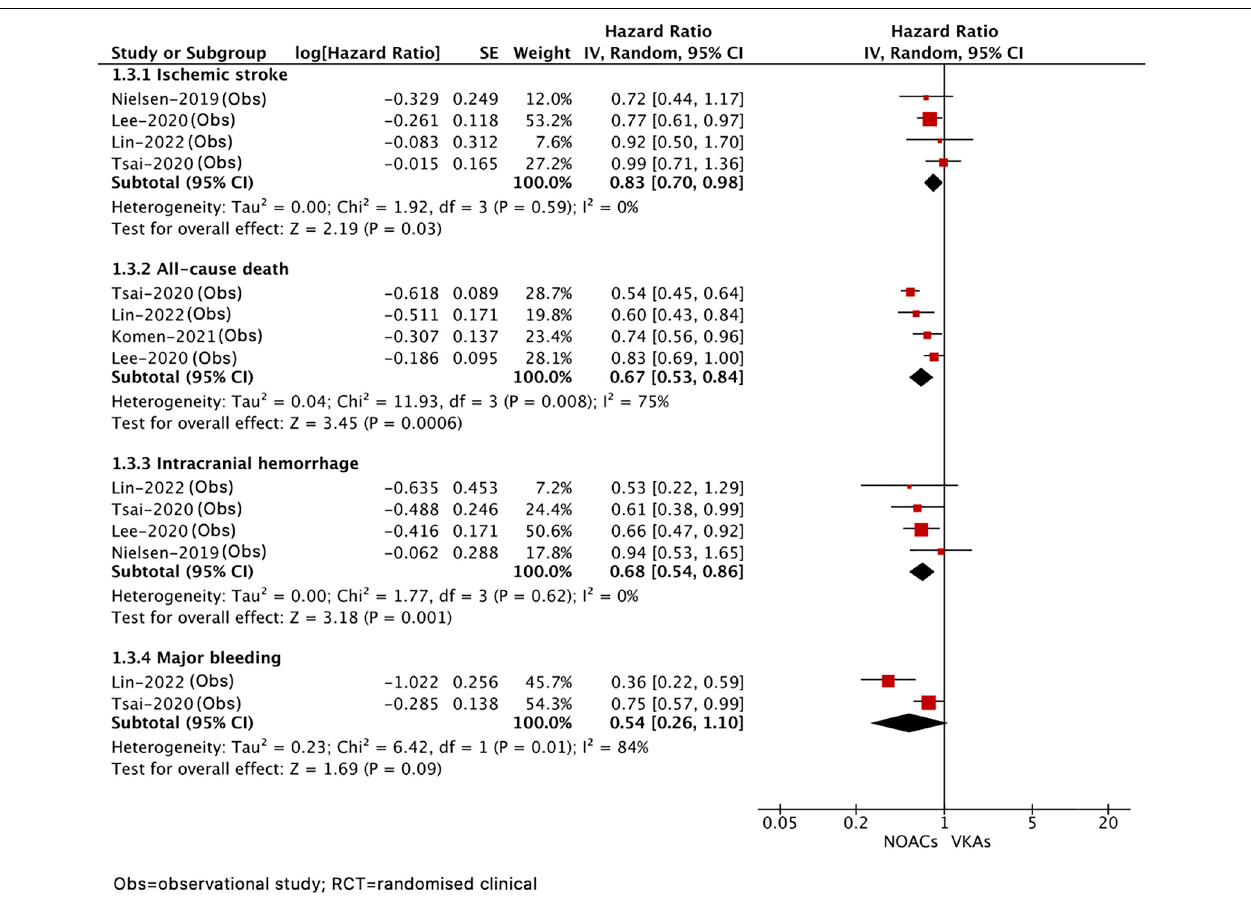
FIGURE 4 | Comparing the efficacy of NOACs with VKAs in patients with AF after ICH. AF, atrial fibrillation; ICH, intracranial hemorrhage; VKAs, vitamin K anticoagulants; NOACs, non-vitamin K oral anticoagulants; CI, confidence interval; IV, the inverse of the variance; and SE, standard